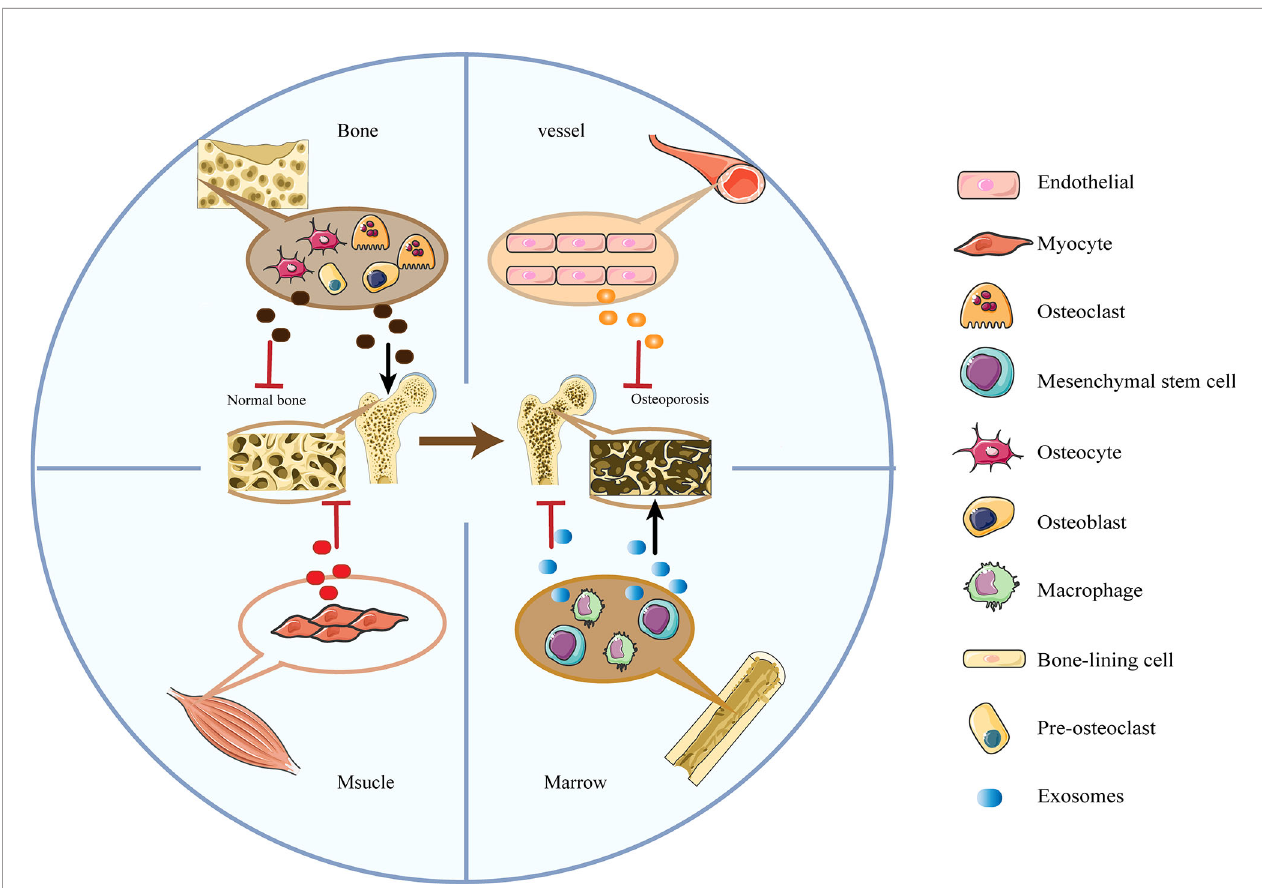
FIGURE 1 | The diplex functions of bone-related cells-derived exosomes in OP. Exosomes secreted by osteoblasts, osteoblasts and mesenchymal stem cells have bilateral effects in promoting and suppressing OP; Exosomes derived from myocytes and vascular endothelial cells mainly inhibit the process of